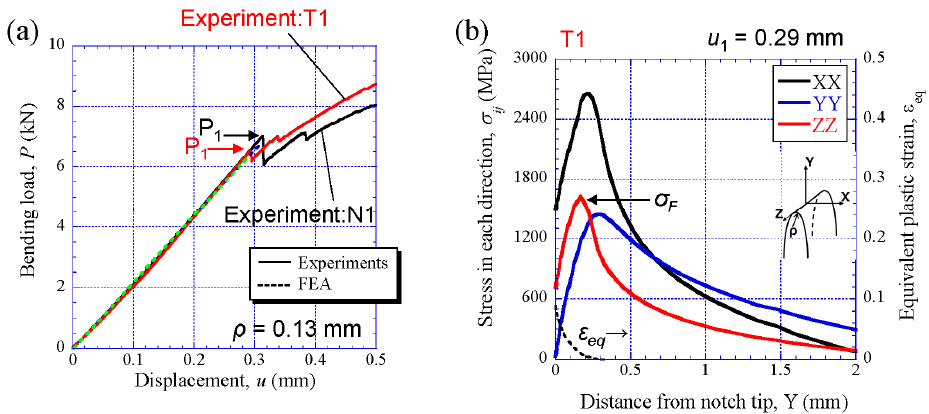
Figure 10. ( a ) Comparison between P - u relations obtained via experiments and FEA in the WBR(N)-1 specimen and the WBR(T)-1 specimen. ( b ) Distributions of stresses and the equivalent strain ε eq near the initial notch tip at u 1 = 0.29 mm obtained via FEA for the WBR(T)-1 specimen.